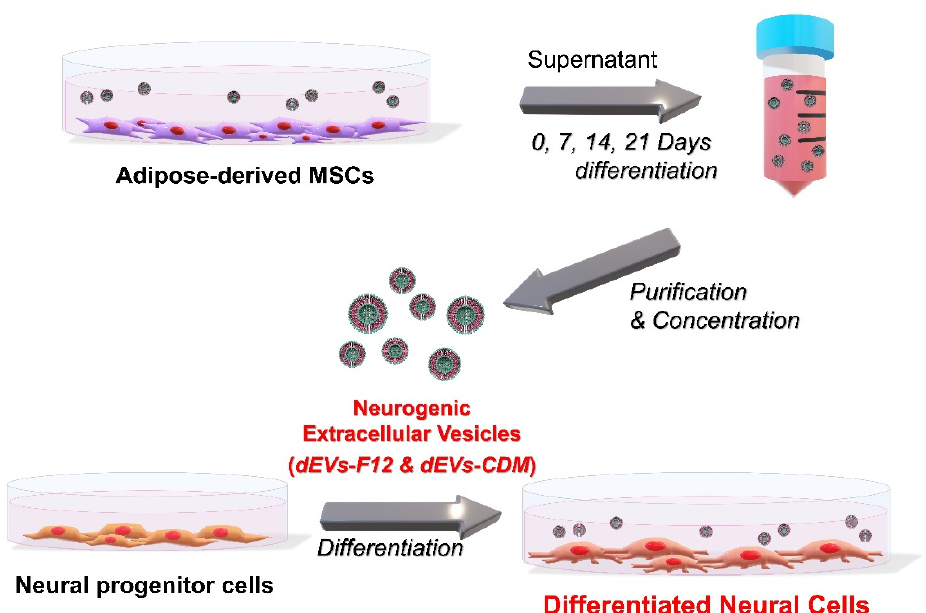
Figure 1. Schematic illustration of dEV isolation. For the effects of dEVs on neuronal differentiation of neural progenitor cells (NPCs), ADMSC-derived supernatant media were collected under neural differentiation conditions at 0, 7, 14, and 21 days.